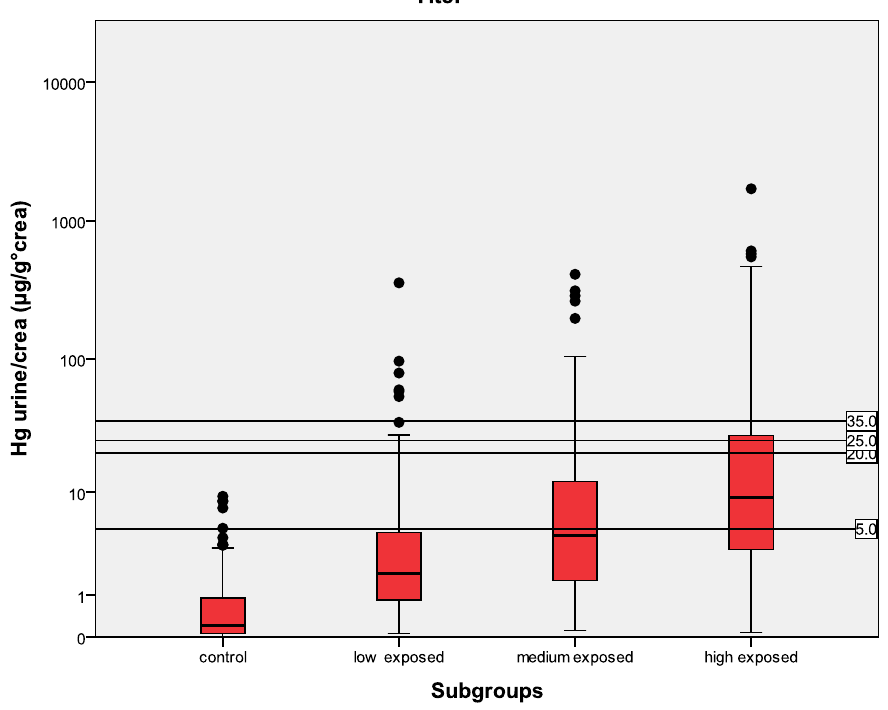
Figure 2. Urine/g crea mercury concentrations in four exposure groups (threshold values HBM I 5.0 µg/g crea, HBM II 20.0 µg/g crea, BAT 25.0 µg/g crea, BEI 35 µg/g